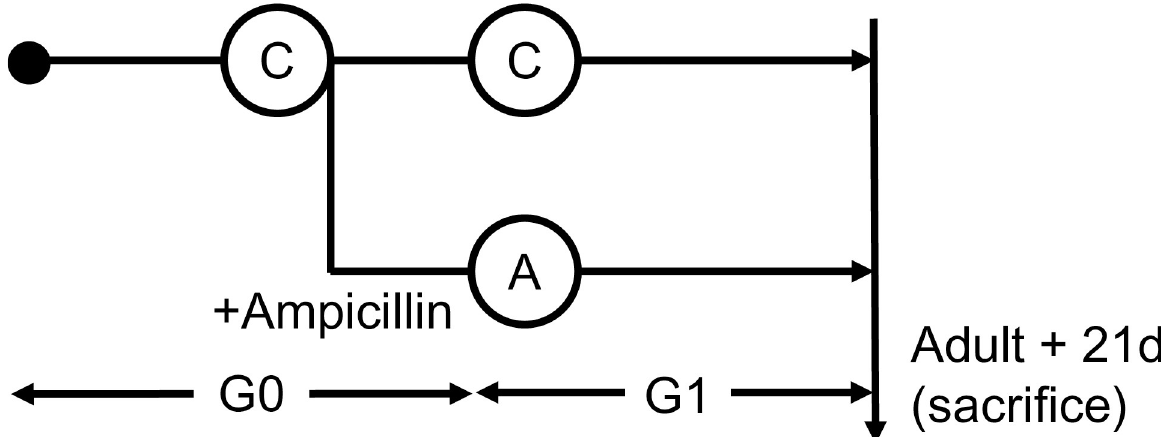
Fig 1. Experimental design depicting ampicillin treatment of B . germanica . The cockroaches were divided into two groups (A and C) and individuals were either treated with ampicillin (A) or left untreated as control specimens (C). Ampicillin was administered to cockroaches from the G1 (i.e., offspring from G0) generation, 21 days after they had reached the adult stage. Whole bodies were then collected and analyzed.